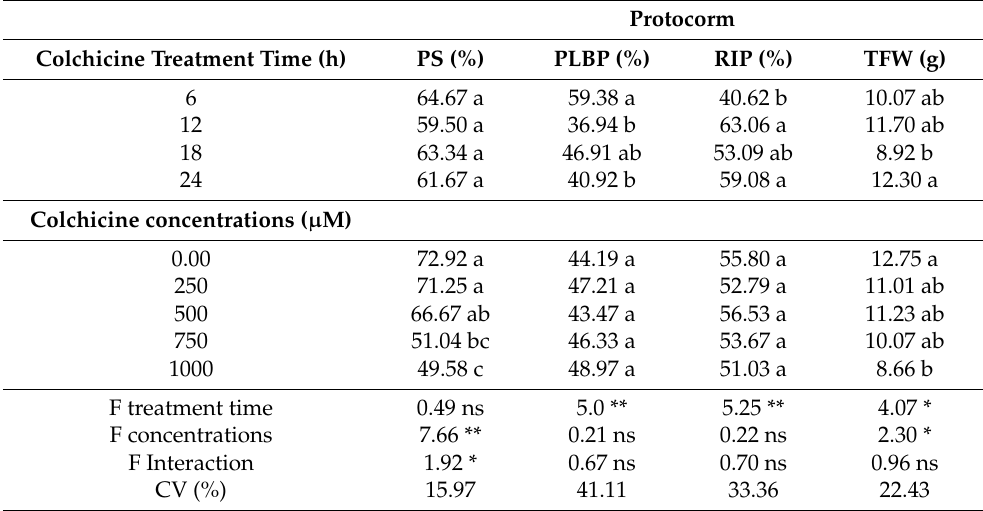
Table 2. Percentages of survival (PS), PLBs proliferation (PLBP), regeneration into plantlets (RlP) and total fresh weight (TFW) of Blc. Haw Yuan Beauty × Blc. Goldenzelle “LC” progeny protocorms exposed to different times and concentrations of colchicine.